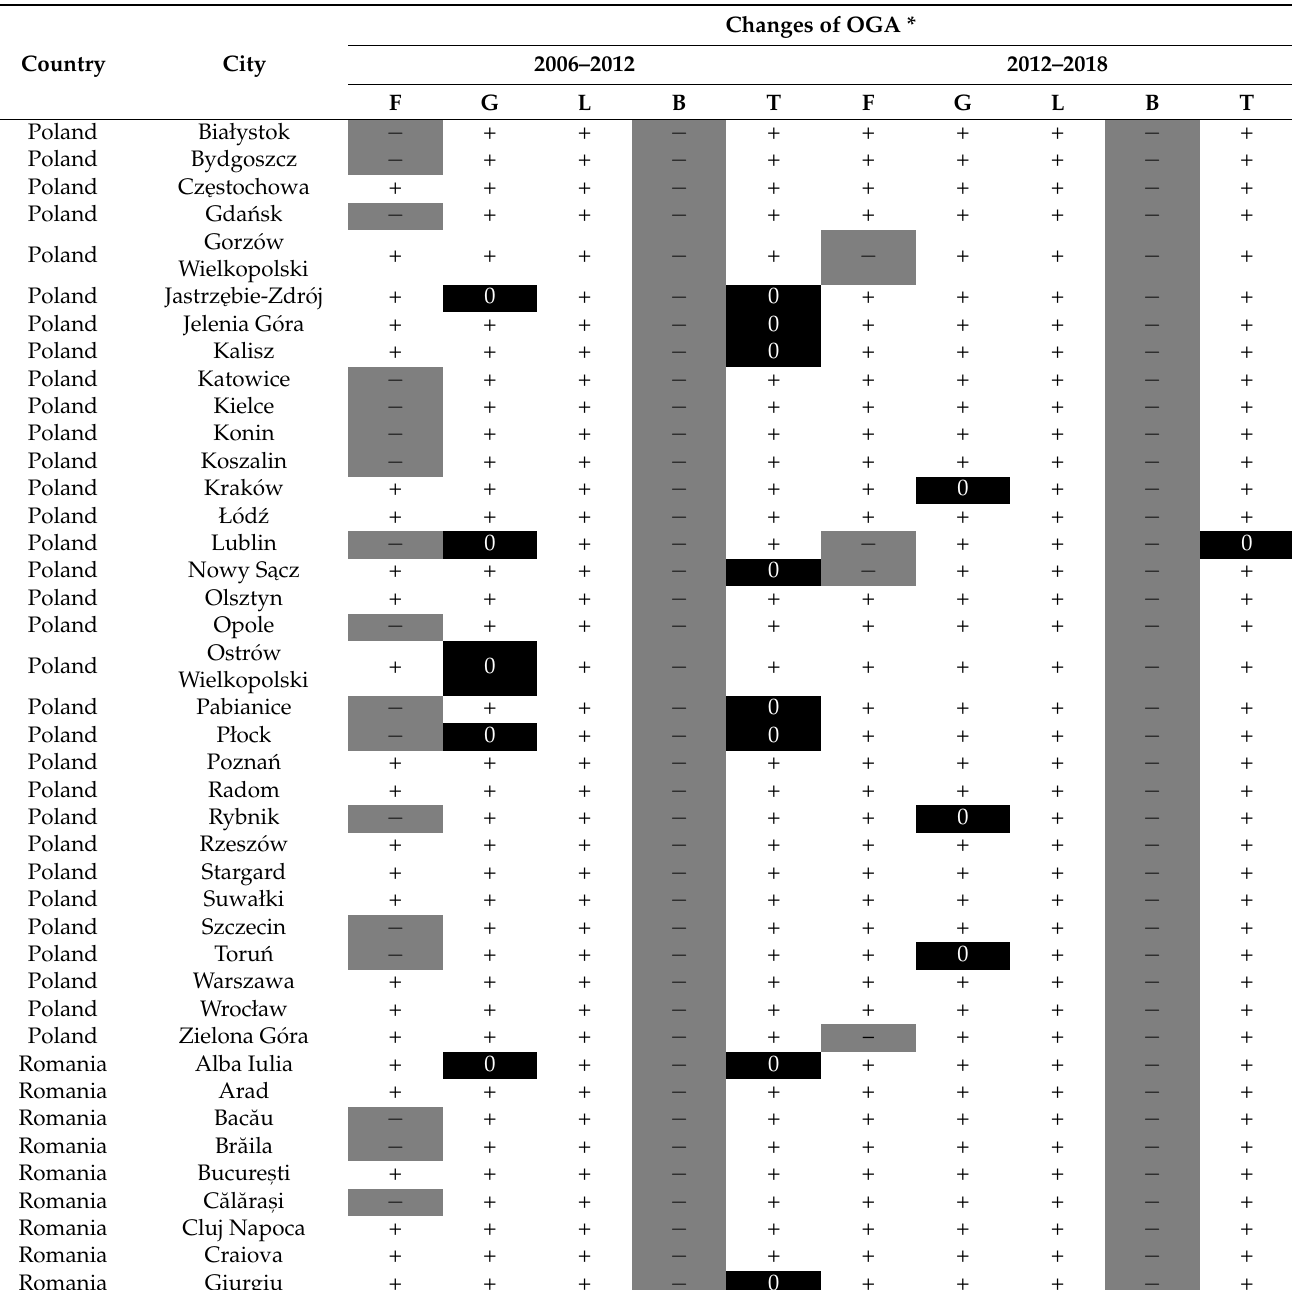
Table 4. Trends of the changes of OGA in the Polish and Romanian cities during